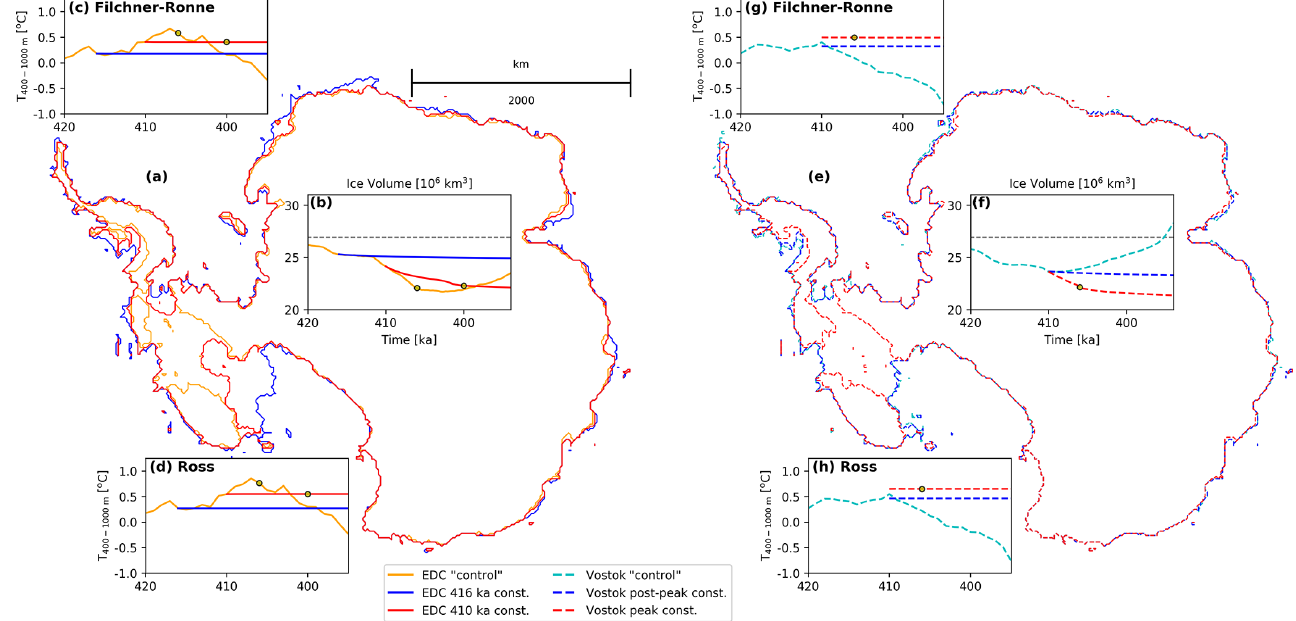
Figure 10. Thresholds for WAIS collapse. (a, e) Grounding lines at 405ka for three EDC-based (solid lines) and three Vostok-based (dashed lines) experiments, respectively (see below for explanation); (b, f) ice volume (10 6 km 3 ), (c, d, g, h) intermediate-depth (400–1000m) ocean temperatures [ ◦ C] for the Filchner–Ronne and Ross ice shelves, respectively. Time series cover the period between 420 and 395ka for both EDC-based (solid lines) and Vostok-based (dashed lines) experiments. The orange line shows the EDC control run, while the cyan line shows the Vostok control run. Blue lines show EDC and Vostok simulations where climate was kept constant and the WAIS did not collapse, while the red lines show EDC and Vostok simulations where climate was kept constant and the WAIS collapsed. Yellow circles show the moment when the WAIS breaks down and an open-water connection between the Ross, Weddell, and Amundsen seas is